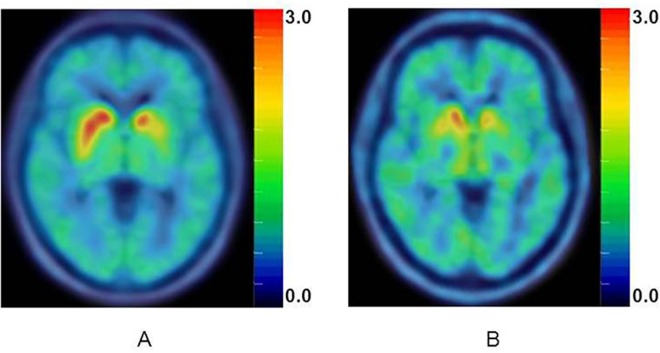
Representative 18F-AV133 SUVR images of PD patients with different CSF tau levels.A: a 60.7-y-old female with t-tau/p-tau of 23.8/6.5 pg/mL. B: a 58.9-y-old male with t-tau/p-tau of 29.8/13.9 pg/mL. The motor scale/MoCA score for the patient A and B were 10/30 and 35/25, respectively. 18F-AV133 ROI SUVRs of patient A and B were: caudate, 1.86 and 1.79; left putamen, 1.74 and 1.30; right putamen, 2.36 and 1.61; ventral striatum, 2.39 and 2.11; raphe nuclei, 1.50 and 1.73; and substantia nigra, 1.48 and 1.42, respectively.